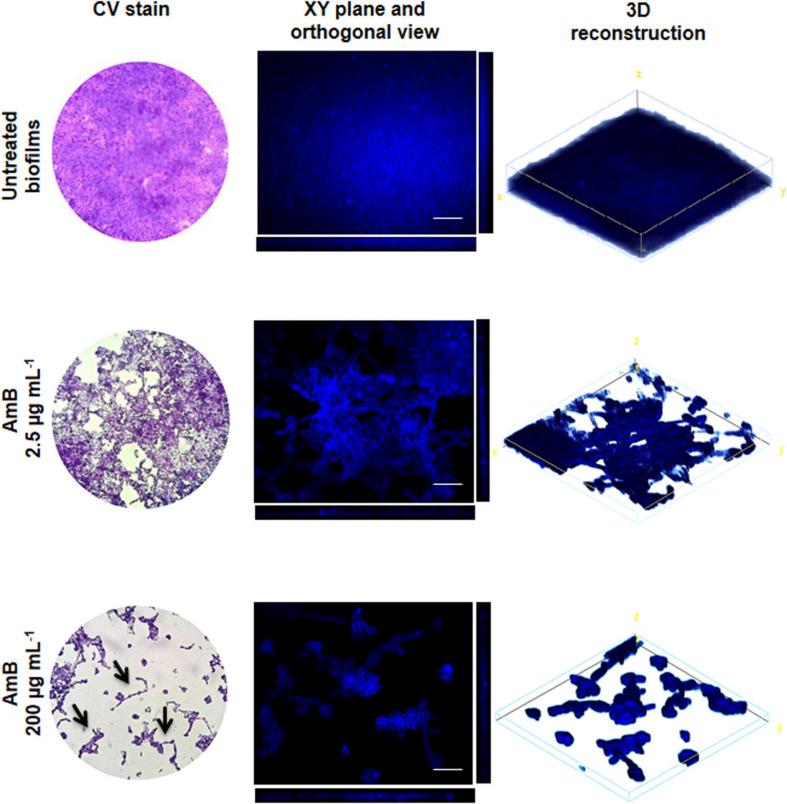
Analysis of Candida tropicalis NCPF 3111 biofilms by light microscope (LM) and confocal laser scanning microscopy (CLSM) images. The images correspond to untreated and treated with Amphotericin B (AmB) 2.5 and 200 μg mL–1 biofilms. For LM, samples were stained by crystal violet (CV) and observed at 400× magnification. CLSM images show XY (top) and XZ (bottom) planes and the 3D image reconstruction of biofilms stained with Calcofluor-White and observed at 600× magnification. Scale bar: 10 μm.